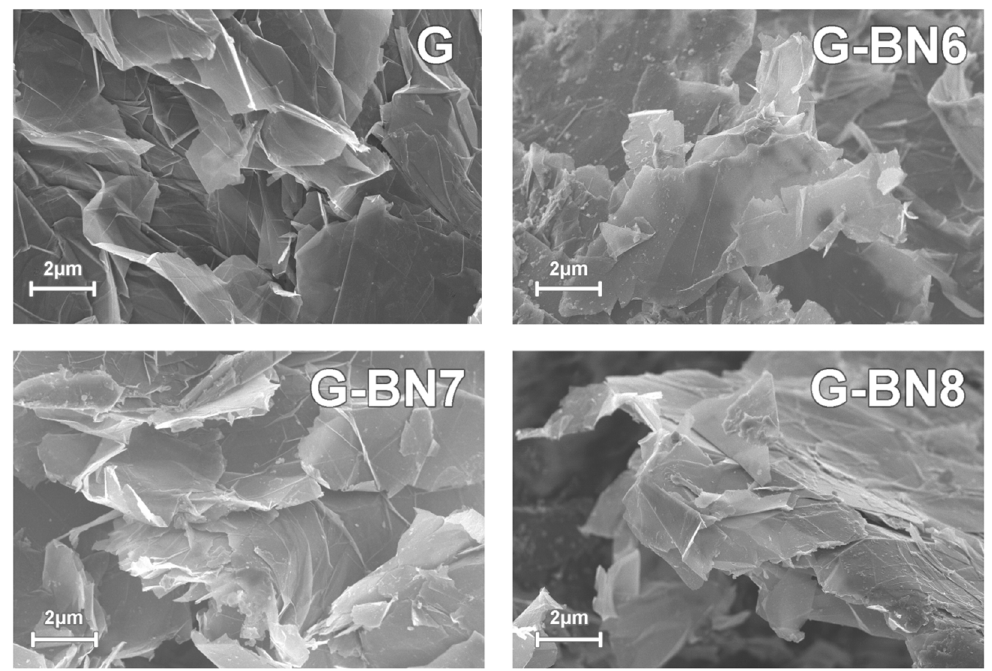
Figure 7. Scanning electron microscopy (SEM) images registered for unmodified graphene ( G ), graphene covered with BN6 ( G-BN6 ) and graphene functionalized with BN7 ( G-BN7 ) and BN8 ( G-BN8 ).